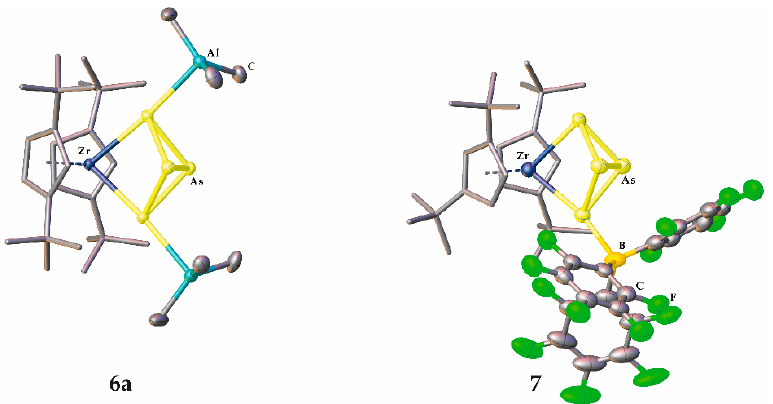
Figure 5. Molecular structures of 6a and 7 in the solid state with thermal ellipsoids at 50% probability level. Hydrogen atoms are omitted, the Cp'' ligands and the [B(C 6 F 5 ) 3 ] ligand are drawn in the tube model for clarity.